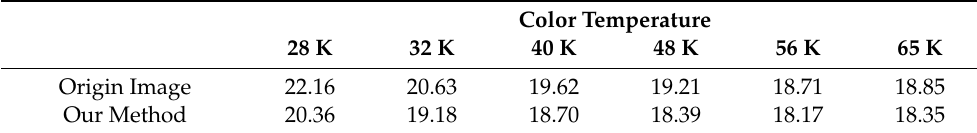
Table 2. Color differences of the original and white-balanced images determined using the CIE2000 test under different color temperatures.